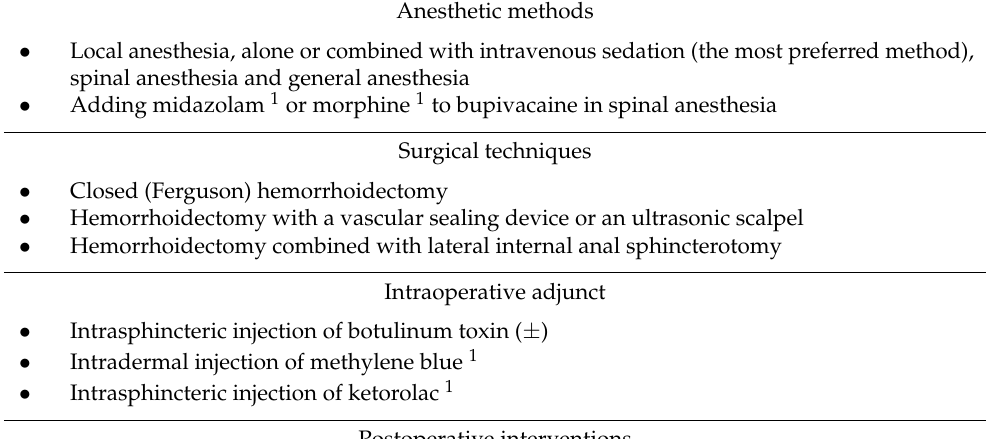
Table 1. Strategies to reduce post-hemorrhoidectomy